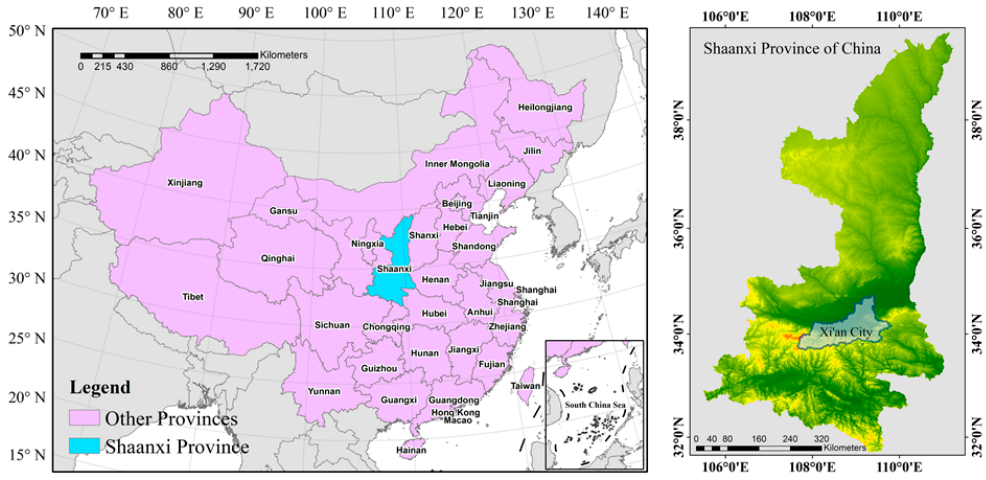
Figure 1. Location map of the study area.